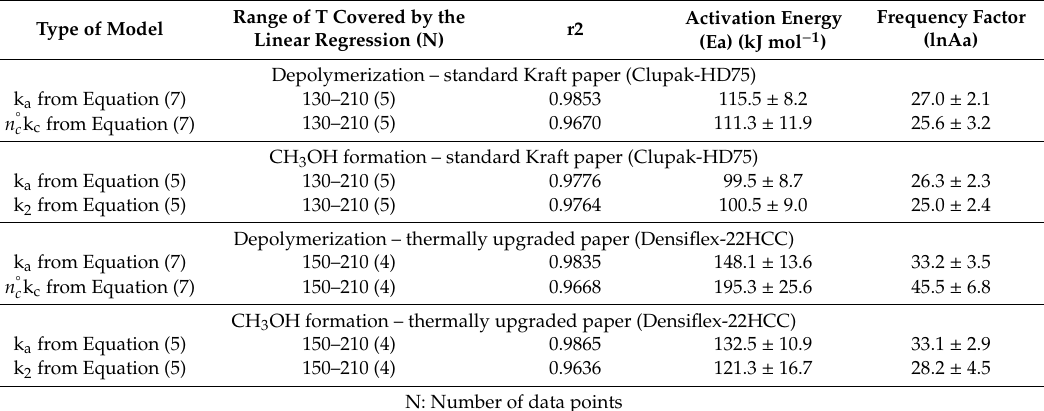
Table 2. Arrhenius parameters of depolymerization and methanol formation for the ageing of standard Kraft paper and thermally upgraded insulating paper (130–210 ◦ C)